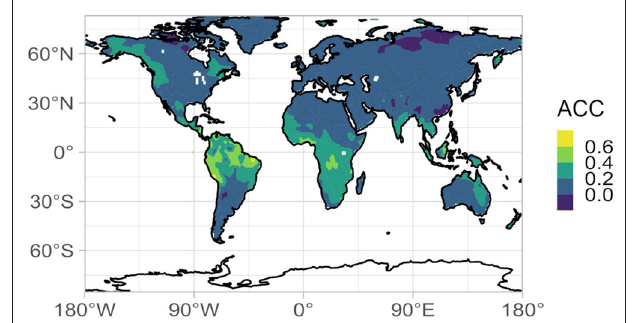
FIGURE 1 | Anomaly correlation coefficient between the 2-month lead SINTEX-F2 ensemble mean 2-meter temperature and the GHCN CAMS 2-meter temperature (Fan and van den Dool, 2008) for the period 1983–2015 (396